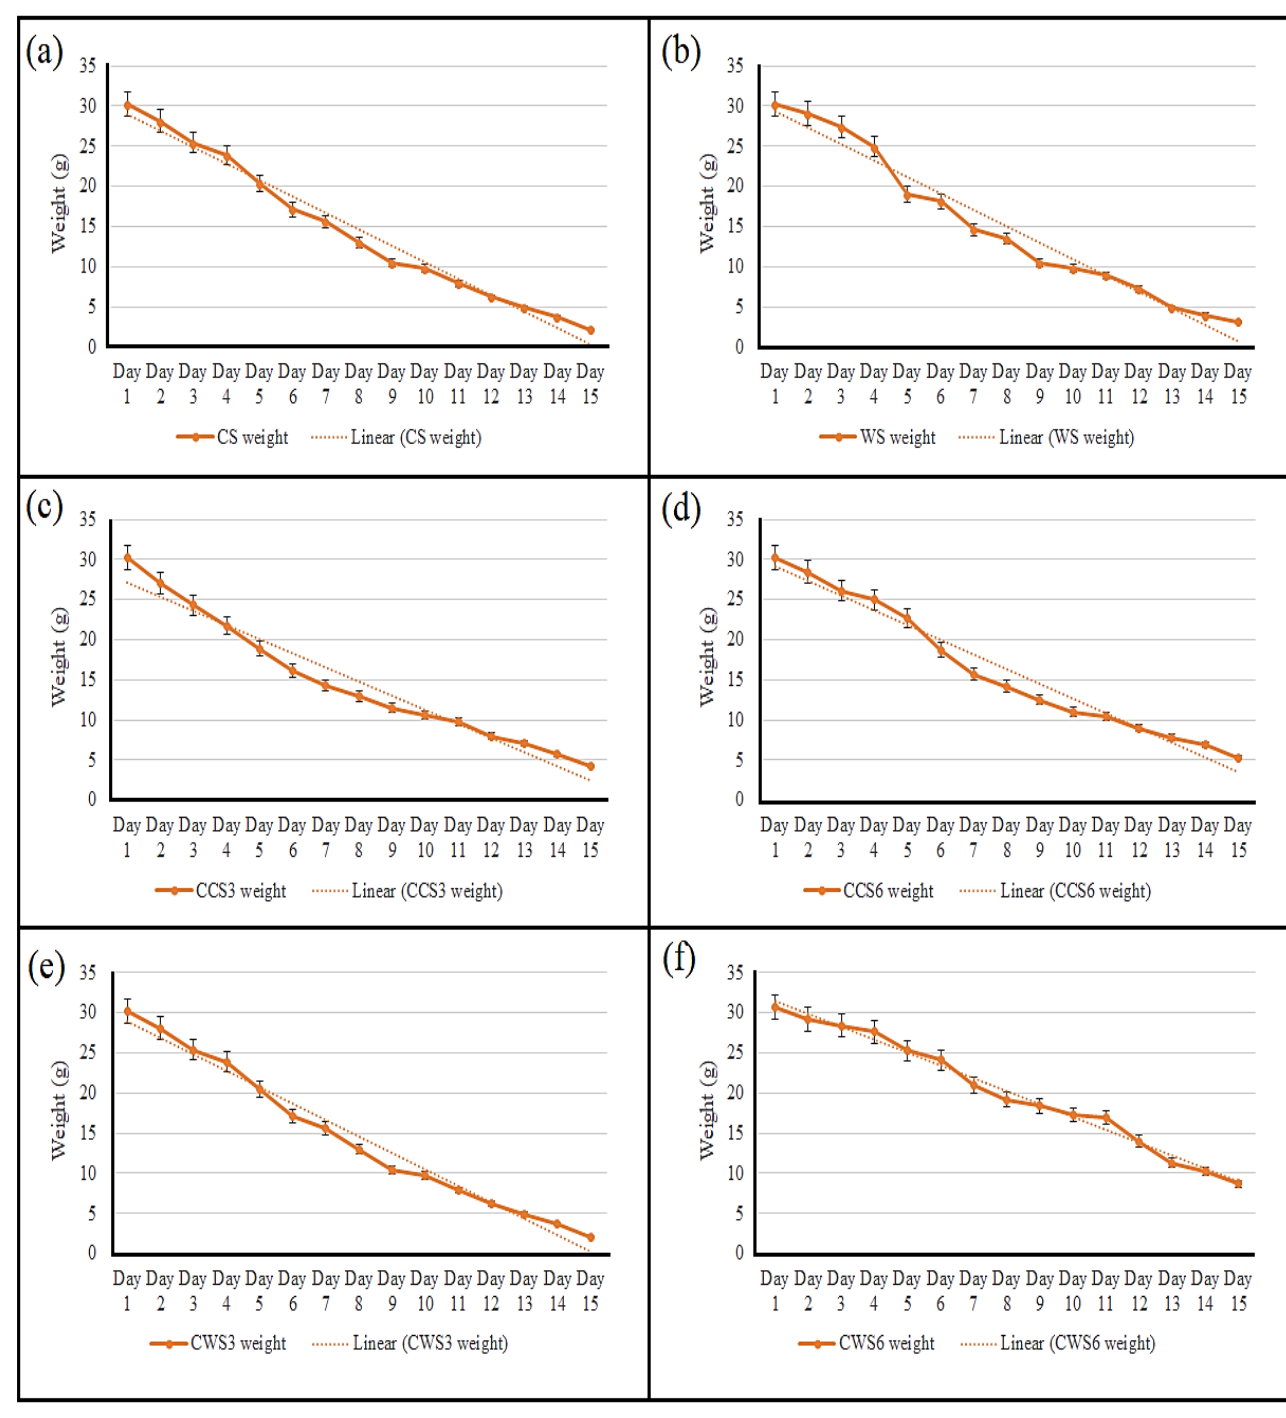
Figure 2. Water evaporation and in-air stability of hydrogel samples; the graphs show the weight reduction in each sample ( a ) CS, ( b ) WS, ( c ) CCS3, ( d ) CCS6, ( e ) CWS3 and ( f ) CWS6 for 15 days.